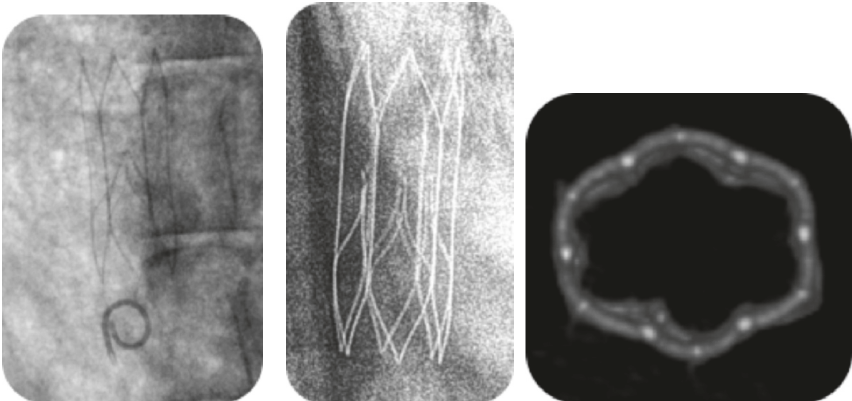
Figure 3: Representative imaging for an animal from the late-incorporation analysis cohort. Left: venogram of the Sentry IVC filter on the day of implantation. Middle: X-ray of the bioconverted filter. Right: CT reconstruction showing bioconversion of the Sentry IVC filter.